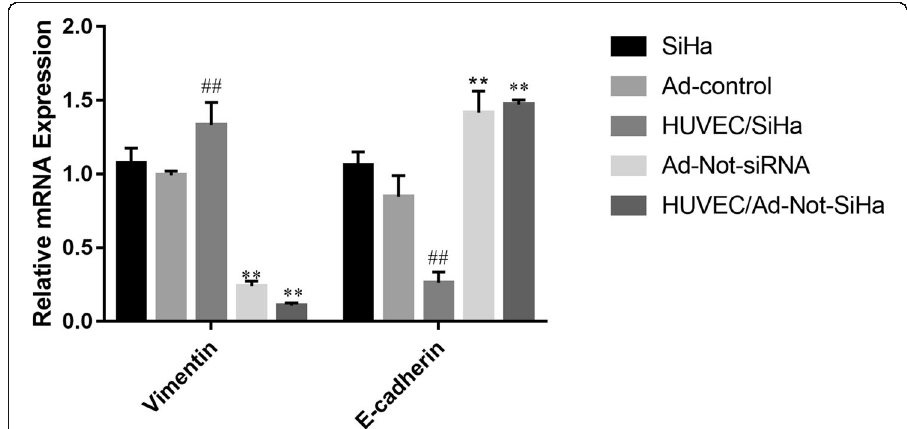
Fig. 3 qPCR was used to detect the expression of vimentin and E-cadherin mRNA in cells. Compared with the Ad-Control group, ## P < 0.01; compared with the HUVEC/SiHa group, ** P <